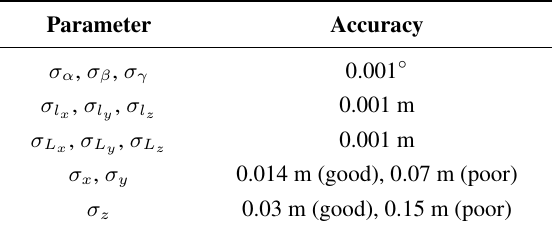
Table 2. System independent accuracy parameters